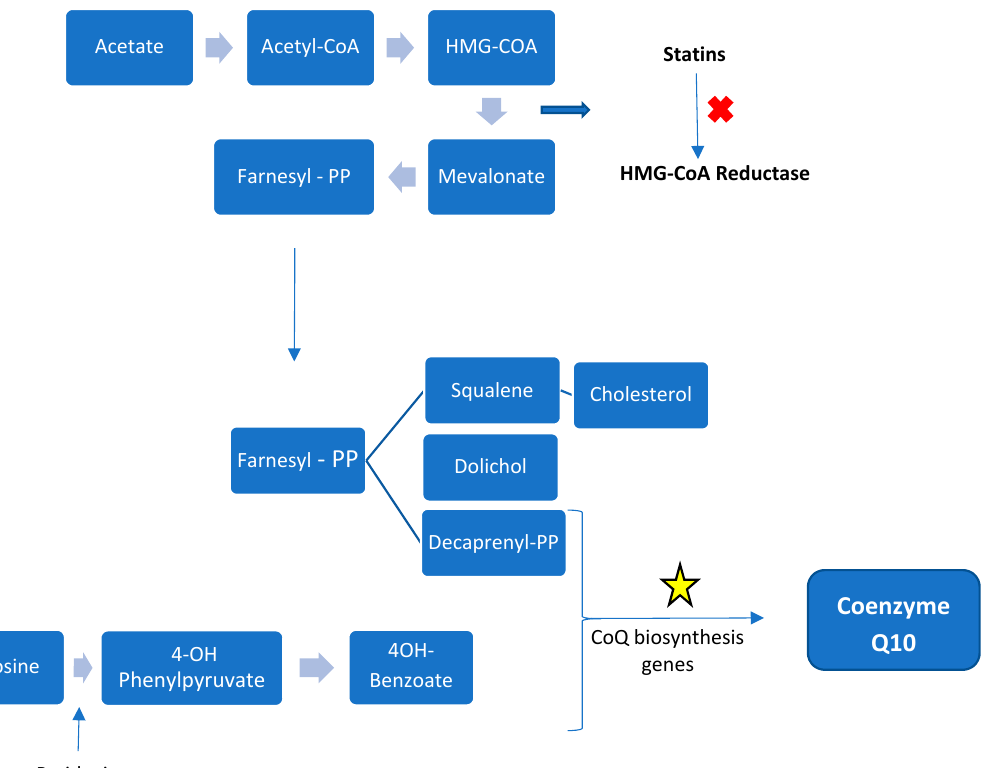
Figure 3. Schematic representation of CoQ biosynthesis. The isoprenoid side-chain derives from the cholesterol and dolichol synthetic pathway from mevalonate, the benzoquinone ring is derived from tyrosine metabolism. The star symbolizes the genes involved in the final synthesis of CoQ 10 .